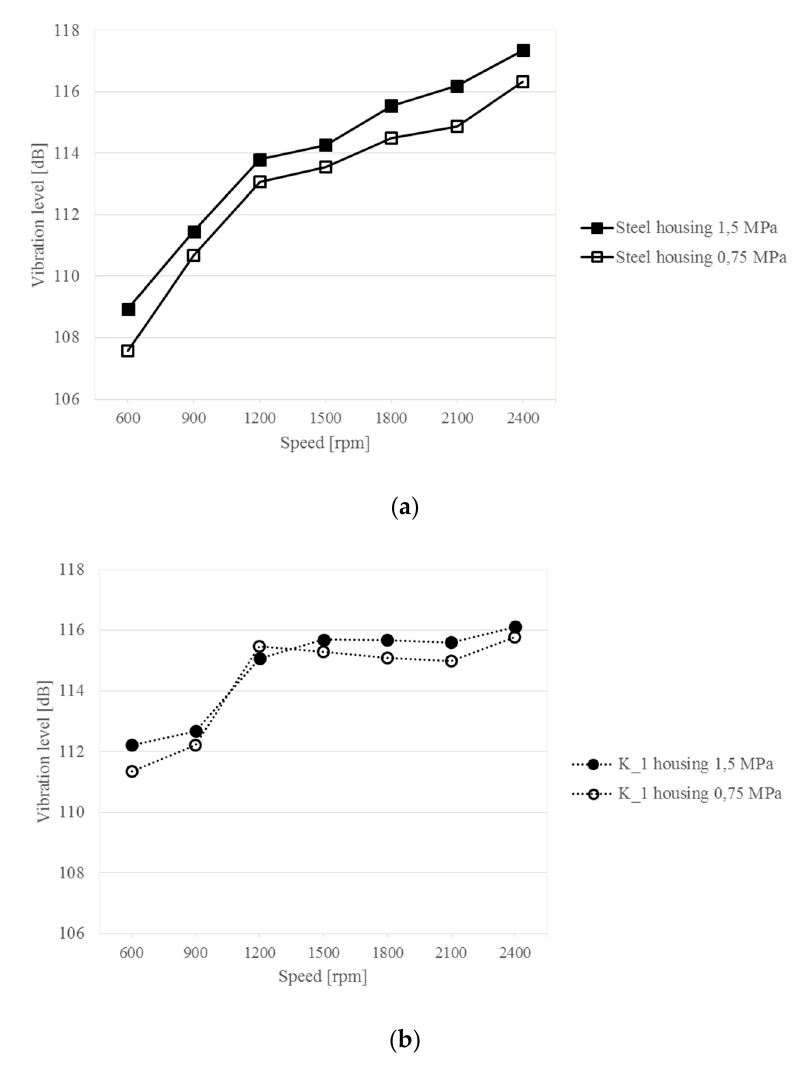
Figure 11. Cont. Figure 11.